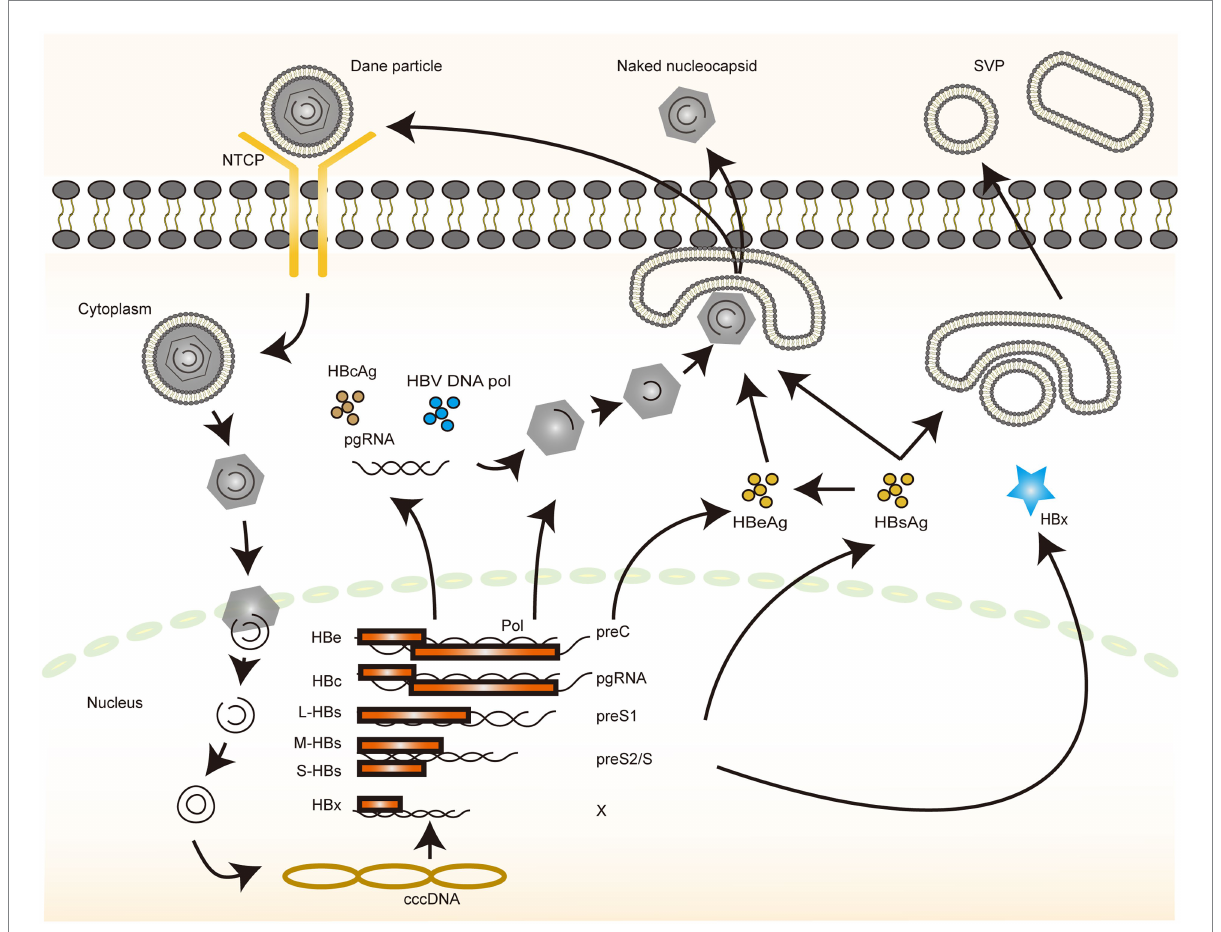
FIGURE 1 The life cycle of HBV. An illustration depicting the life cycle of HBV. The different color blocks and lines indicate different molecules, and the direction of the arrows indicates the various steps in the process through which HBV completes its